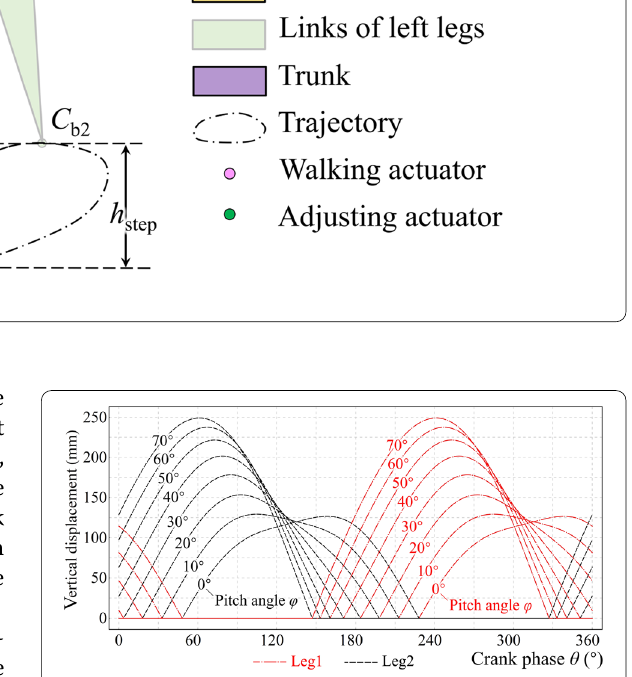
Figure 4 Foot end vertical displacements of